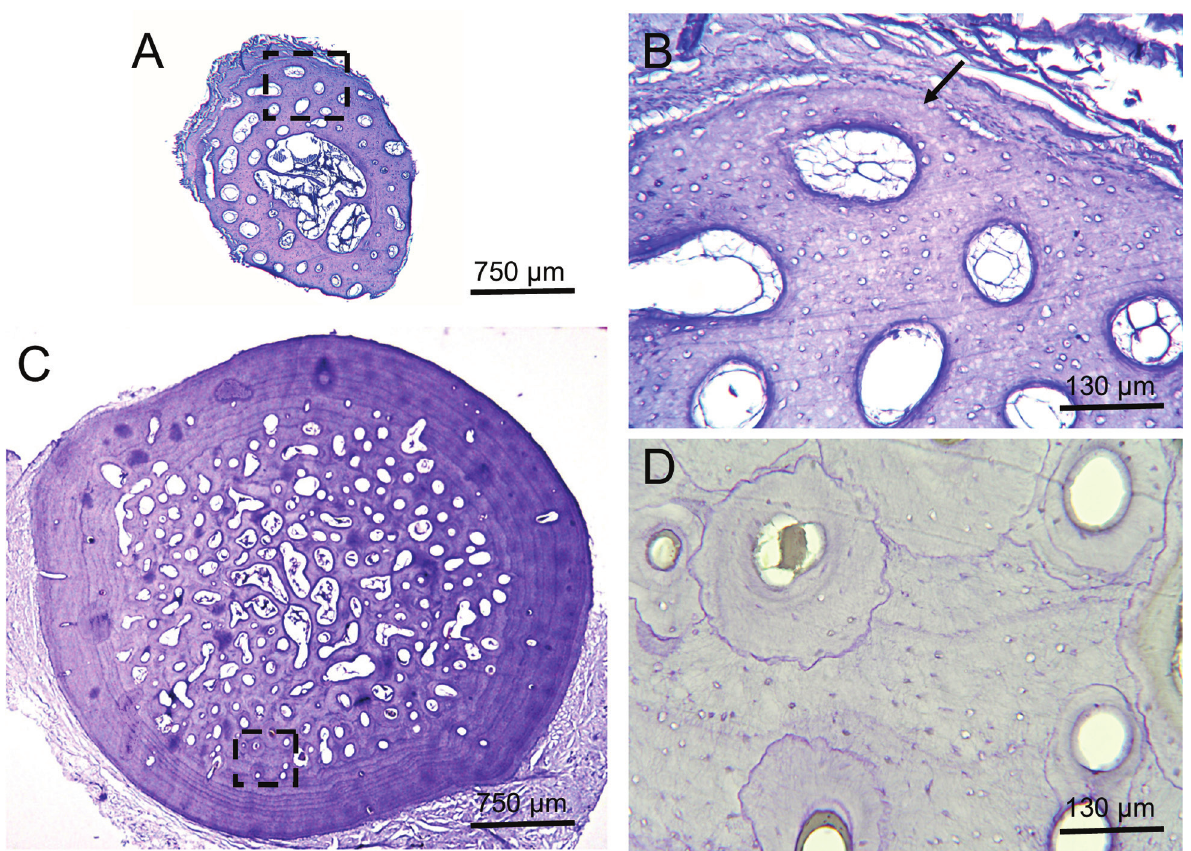
Figure 3. Representative phalanx cross-sections at the diaphyseal level of C. caretta . A) ID36910, in captivity for 16 months, undetermined sex, CCL = 14 cm. B) Higher magnification of the dashed square shown in Fig. A): note one LAG at outer bone mar - gin (arrow). C) ID 69155, female, CCL = 80.5 cm. D) Higher magnification of the dashed square shown in Fig. C) showing some Haversian systems.